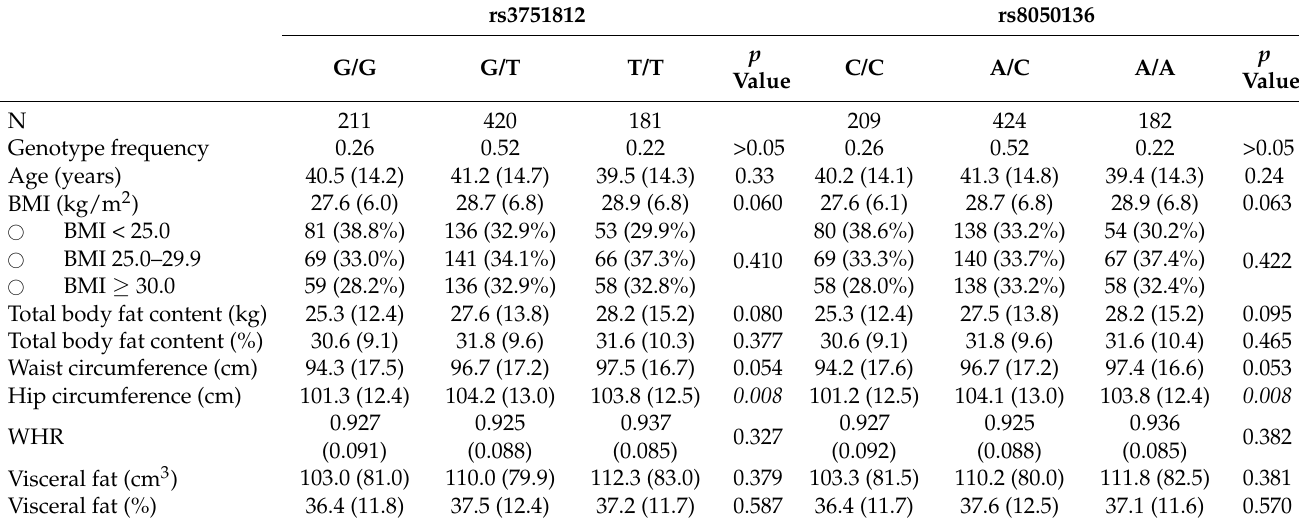
Table 1. Characteristics of participants stratified by rs3751812 and rs8050136